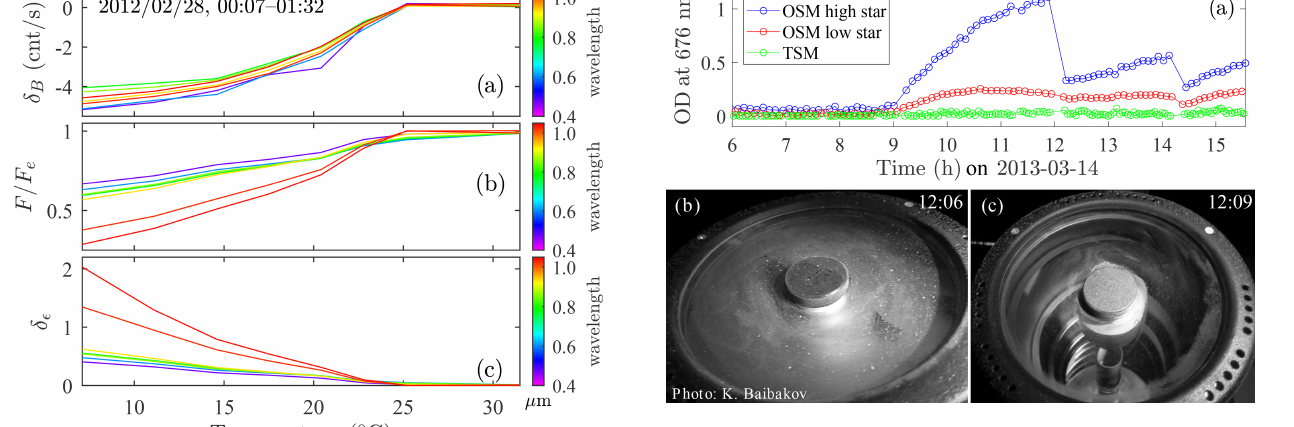
Figure 25. Extreme throughput degradation event caused by frost formation on the telescope corrector plate (Barrow campaign). The (cid:49) TSM auto-calibrating mode effectively compensates, in real time, for any common-mode throughput degradation (attenuation increase) and, accordingly, remains largely unaffected by the frost (open green circles in panel a ). In contrast, the OSM mode is very sensitive to the apparent attenuation of the high and low stars that constitute the TSM pair (respective blue and red open circles in panel a ). The two rapid decreases in the OSM ODs correspond to cleaning events at 12:09 and 14:20UTC. Panels (b) and (c) show the collector plate just prior to (12:06UTC) and just after cleaning (12:09UTC),